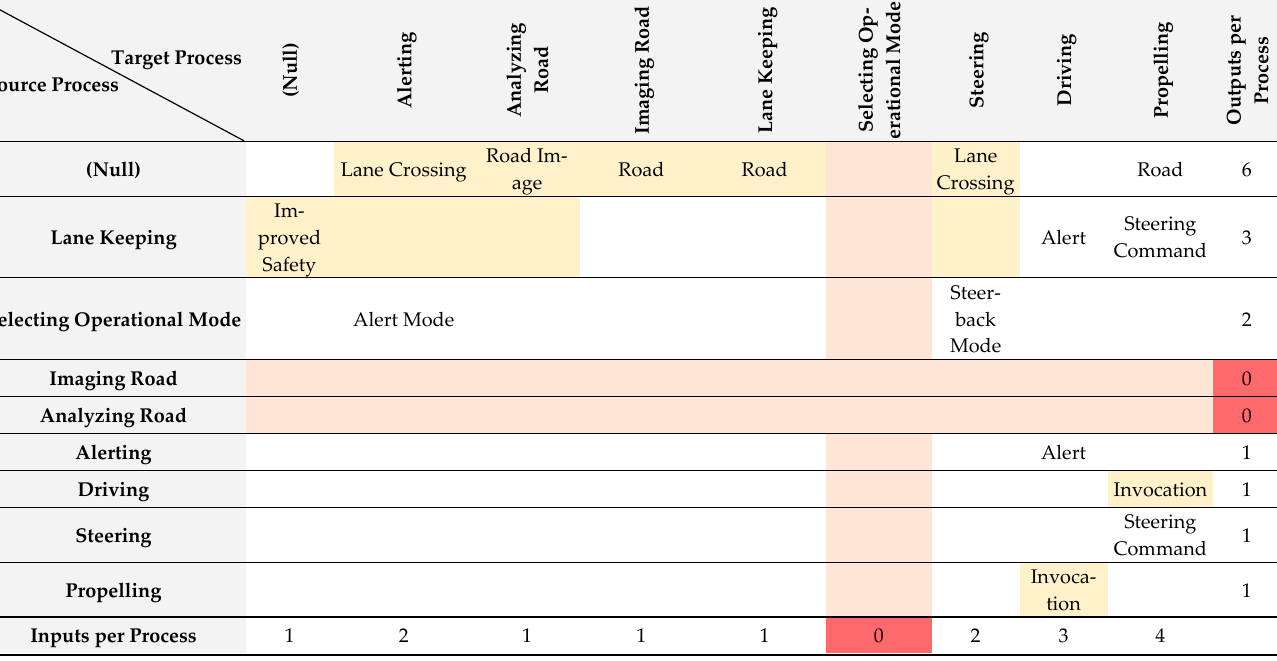
Table 8. POP matrix of LKS model maps processes to each other via onput exchange, instrument providing, and invocation. Color coding highlights discrepancies and potential issues: Red cells with a value of 0 indicate processes without inputs or outputs. Lightly-colored cells need further attention.